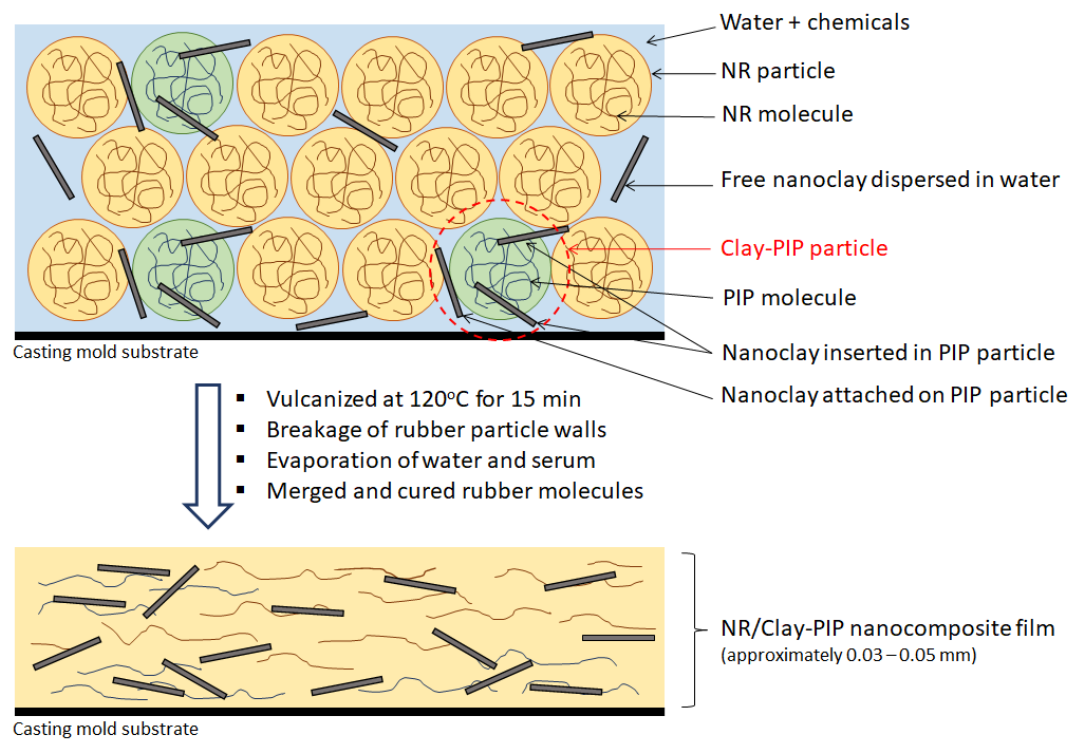
Figure 9. Film formation of the NR/Clay-PIP nanocomposite .